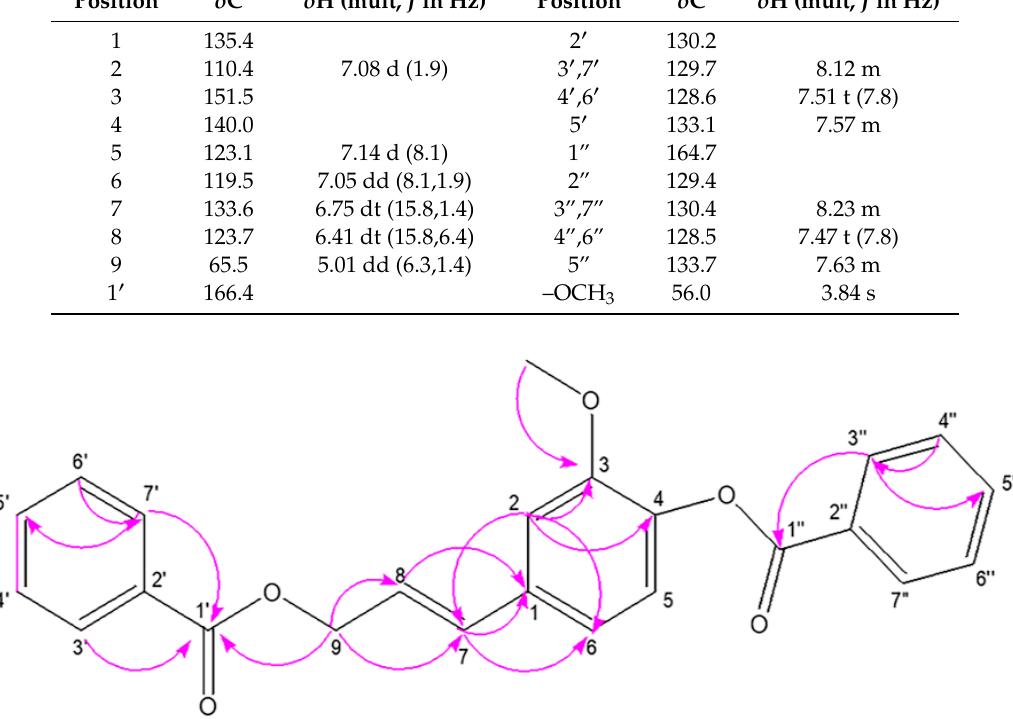
Figure 2. The key HMBC correlations for stybenpropol A.